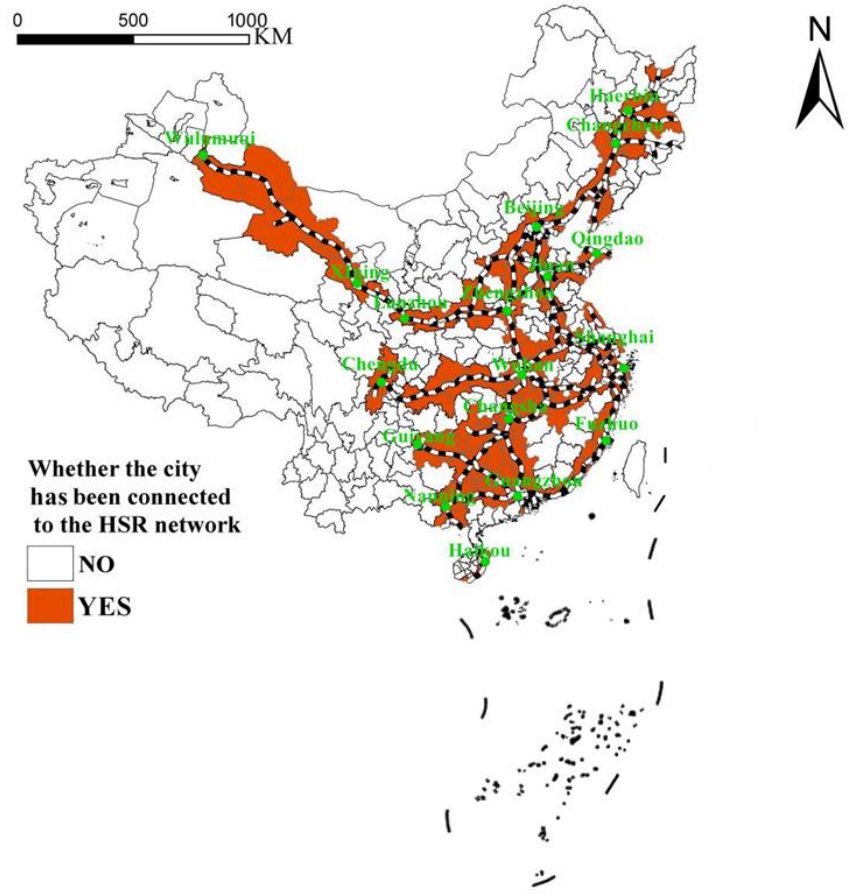
Figure 2. HSR lines and stations in the prefecture-level cities.